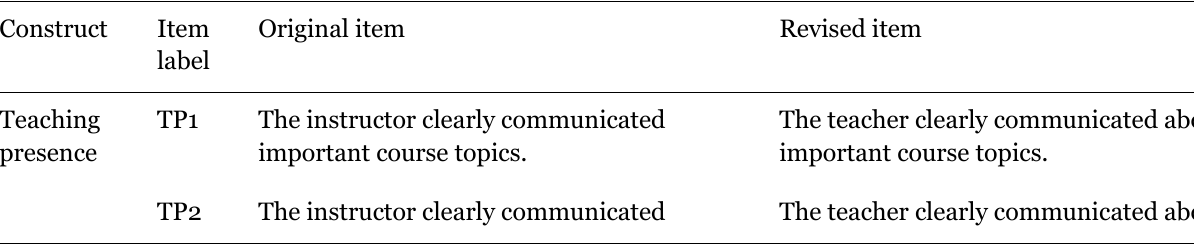
Comparing the Original and Revised